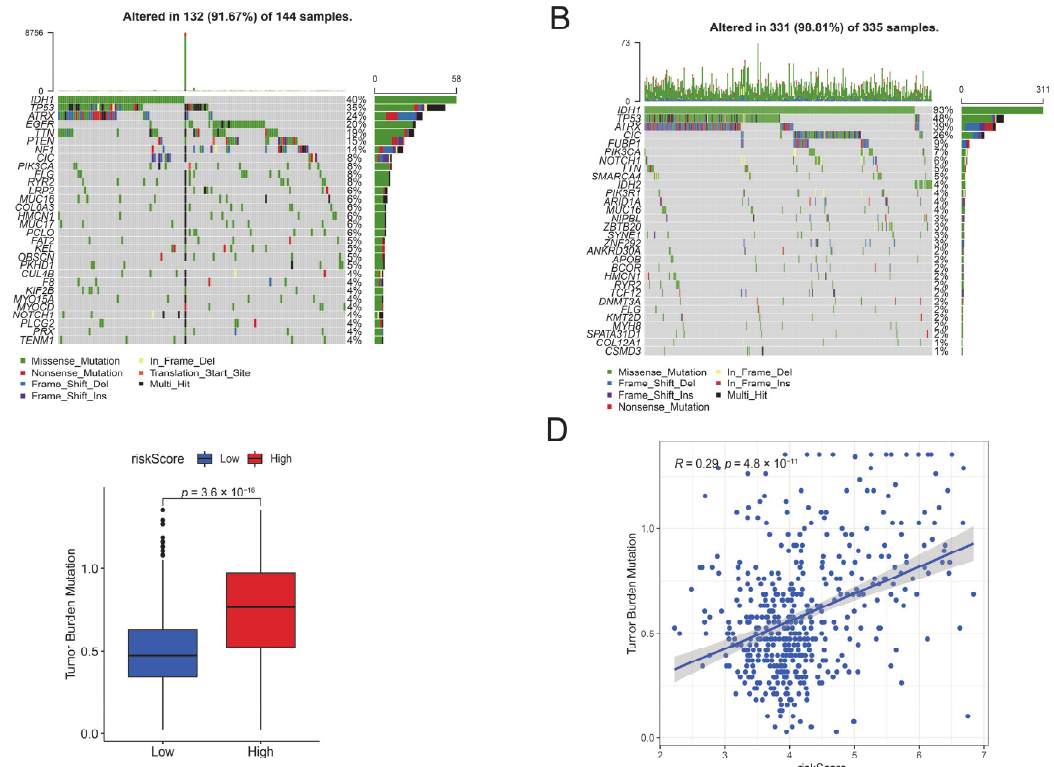
Figure 10. Distinct somatic mutation status in the different PyroScore groups. ( A ) Most frequently mutated genes in the high-risk group. ( B ) Most frequently mutated genes in the low-risk group. ( C ) Comparison of tumor mutation burden between the low-and high-risk group. ( D ) The correlation between PyroScore and tumor mutation